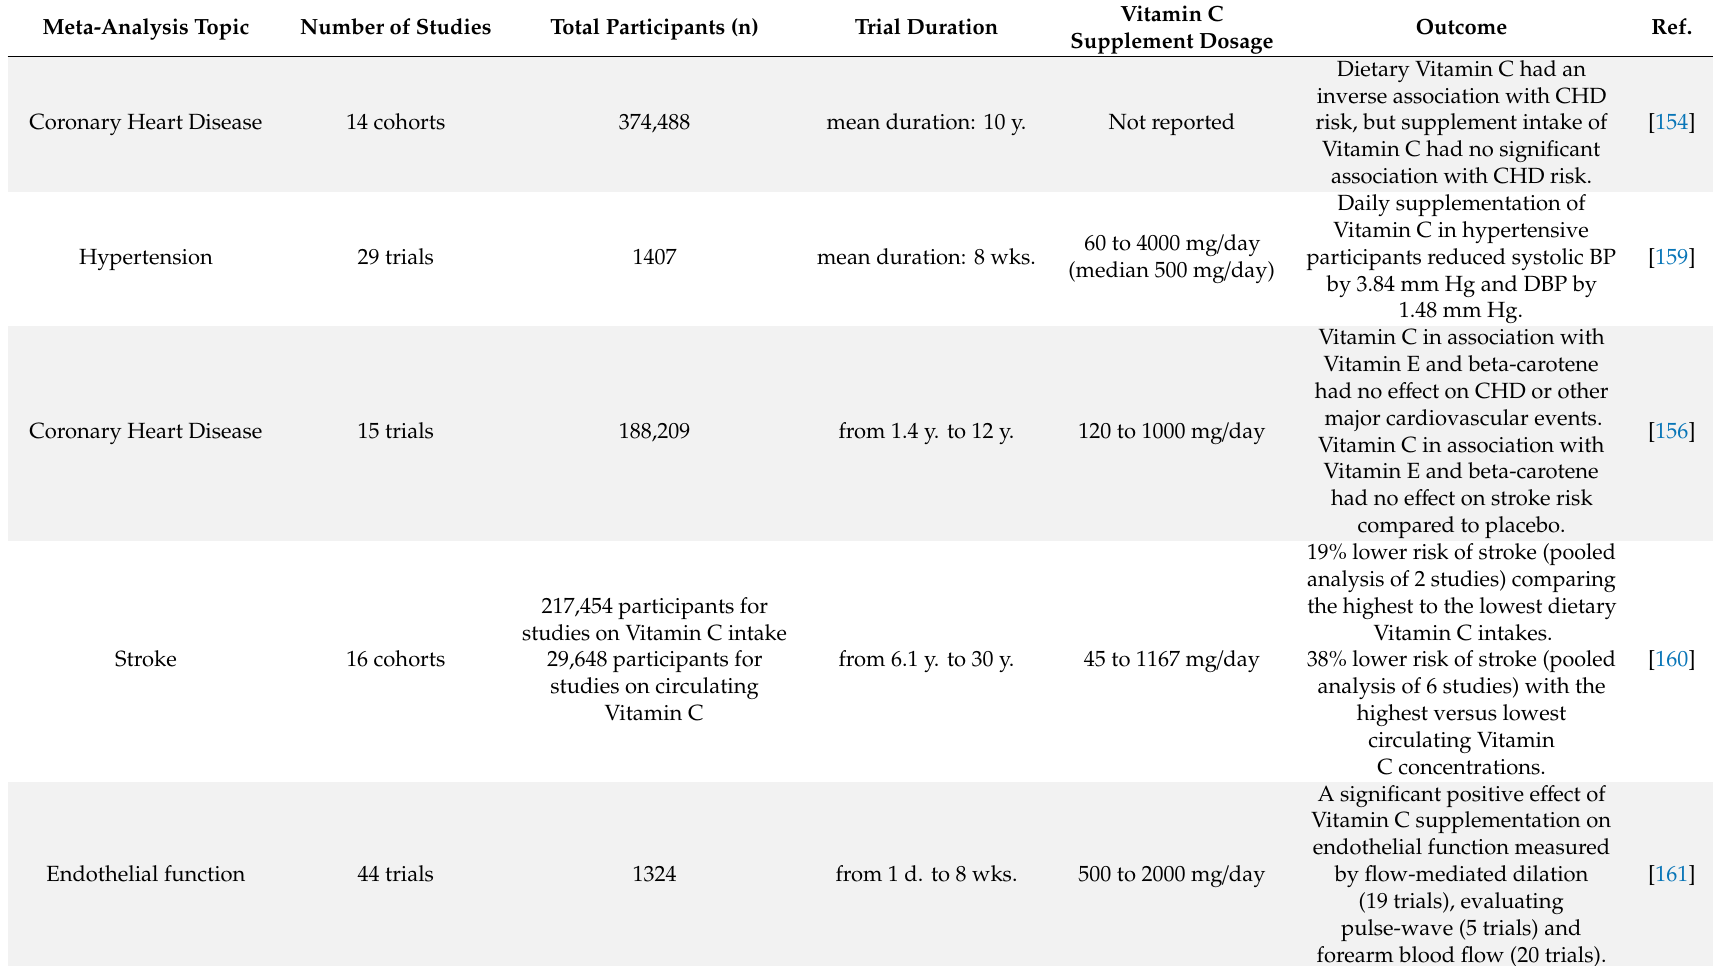
Table 2. Main meta-analyses investigating the correlation between vitamin C intake or its plasma levels and cardiovascular disease